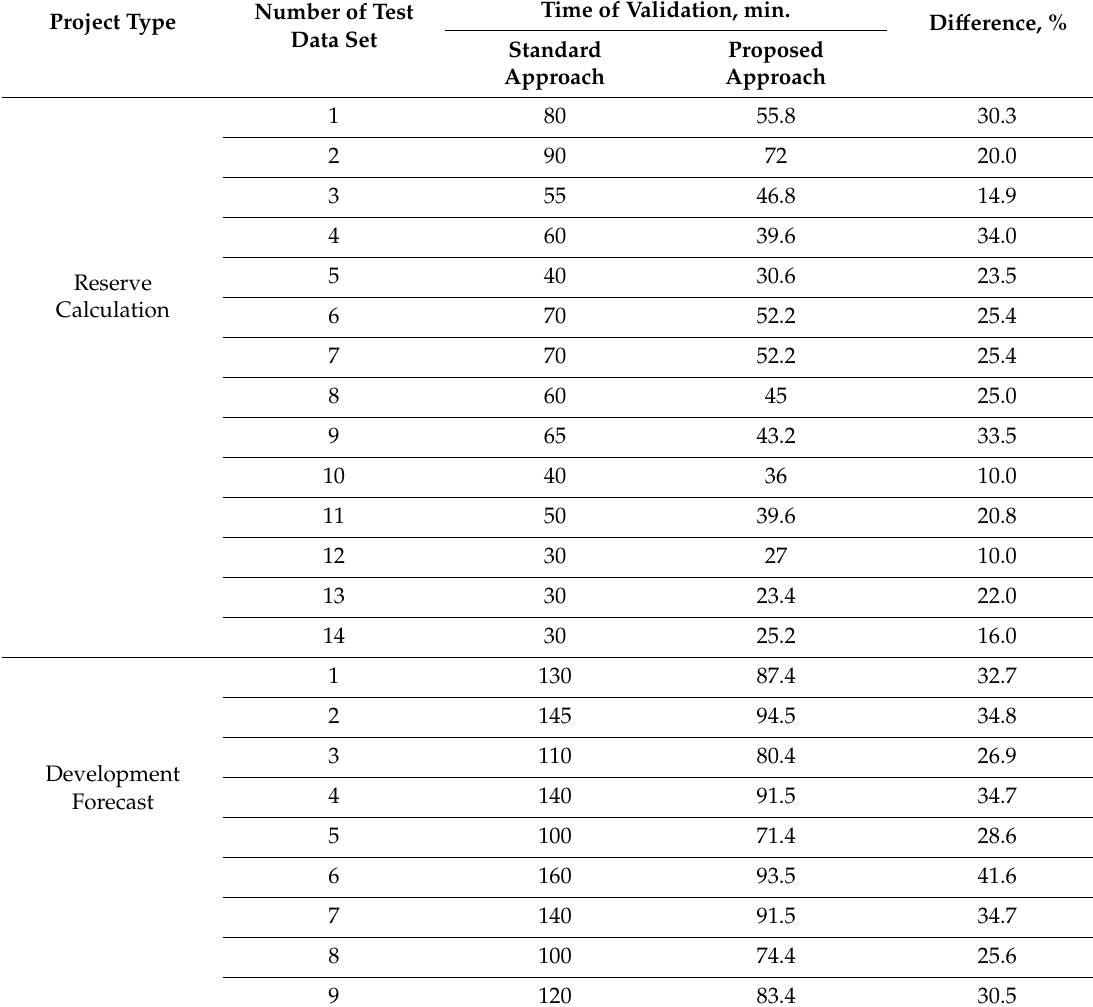
Table 3. Measurement results of the runtime of the initial data validation by